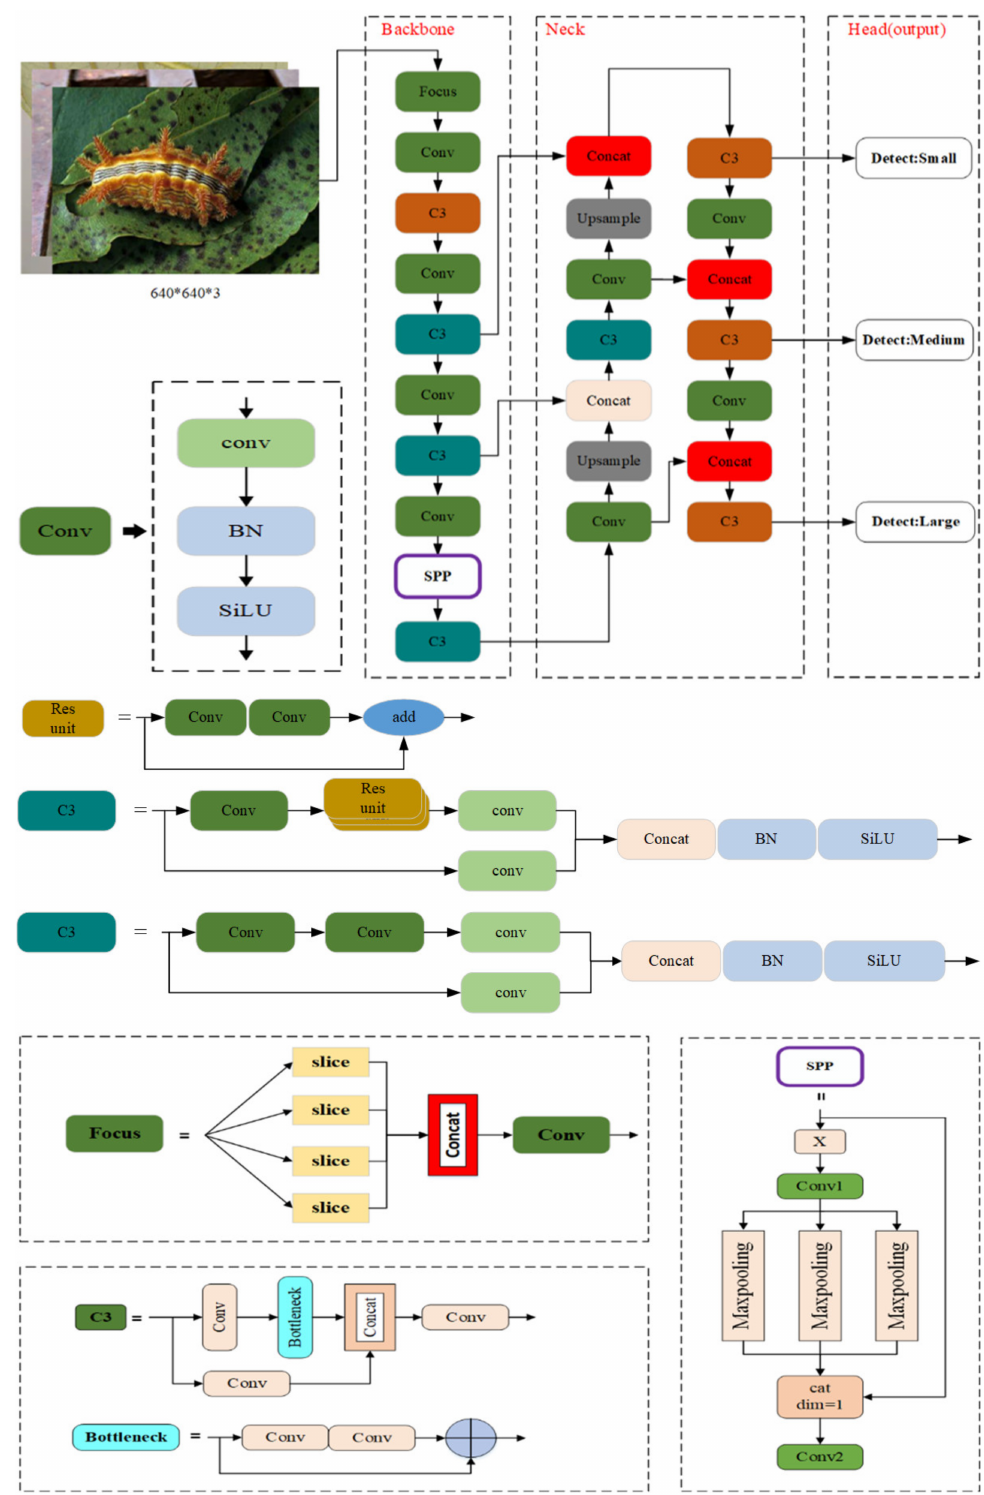
Figure 3. The structure of the YOLOv5m network. The backbone, neck, and output are its three main components. Feature extraction part of the YOLOv5m network includes Conv module, Focus module, C3 module, and SPP